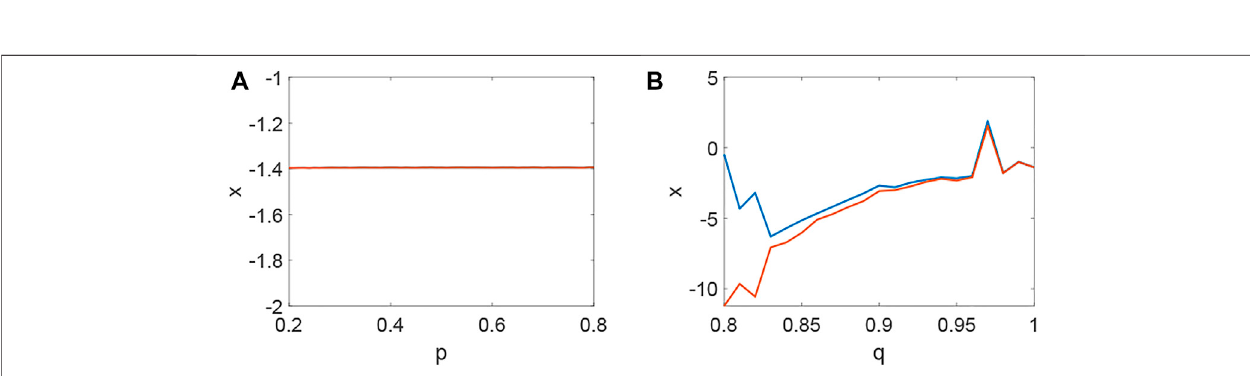
FIGURE 10 | The bifurcation about p , q when τ = 65. (A) The inexistence bifurcation about p when q = 0. (B) The bifurcation about q when p = 0.1.